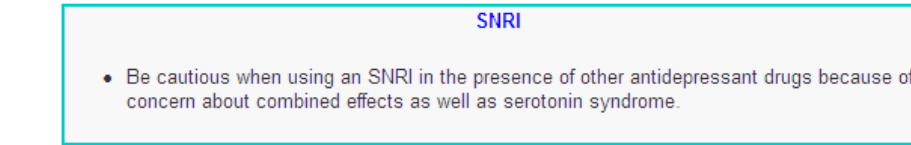
Figure 3. An example "hover box" linked to the box labeled "SNRI". SNRI=serotonin–norepinephrine reuptake inhibitor.